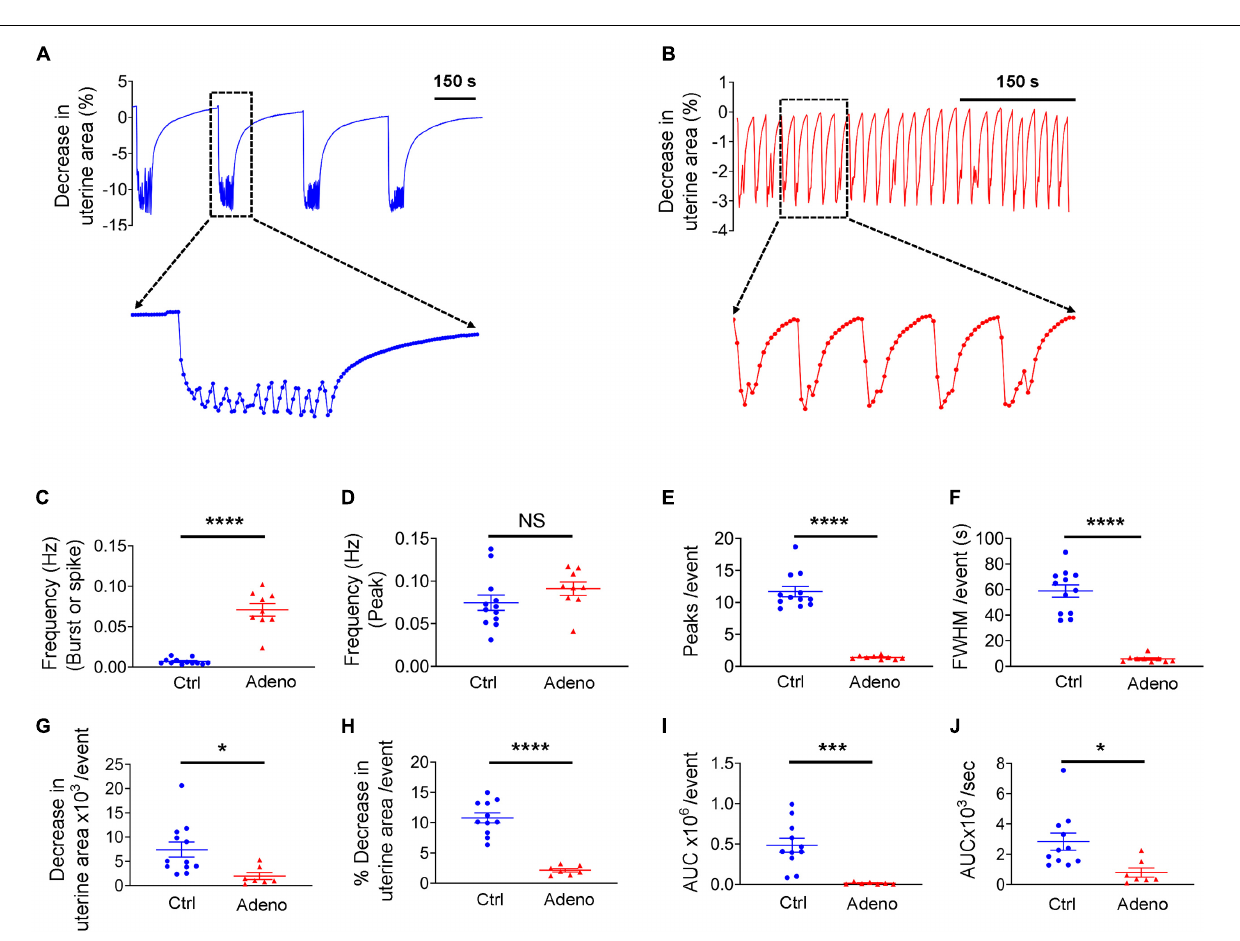
FIGURE 7 | Changes in uterine peristalsis in neonatal adenomyotic mice. (A) Typical peristalsis events in uterine slices from postnatal day (PND) 14 mice after treatment with the vehicle for tamoxifen (Ctrl). A burst event as marked with the dotted line box is shown in an expanded time scale. (B) Typical peristalsis events in uterine slices from PND14 mice after treatment with tamoxifen (Adeno). Five events marked with the dotted line box are shown in an expanded time scale. (C) Frequency comparison between Ctrl mice and Adeno mice at PND14 when a burst or a spike was counted as an event (the same convention is applied to panels E–J ). (D) Frequency comparison between Ctrl mice and adeno mice at PND14 when a peak was counted as an event. (E) Comparison on peak numbers/event between Ctrl and Adeno mice at PND14. (F) Full width at half maximum (FWHM)/event in Ctrl and Adeno mice at PND14. (G) Changes in uterine slice absolute areas/event in Ctrl and Adeno mice at PND14. (H) Changes in slice relative areas/event in control and adenomyotic mice. (I) AUC/event in Ctrl and Adeno mice at PND14. (J) Contraction intensity (AUC × Frequency) comparison between Ctrl and Adeno mice at PND14. Note that each data point in panels (C–J) is an average value from multiple slices in a mouse, and each slice was recorded for ∼ 1 h. N.S., no statistical significance, * P < 0.05, *** P < 0.001, **** P < 0.0001 with unpaired Student’s t -test [ N = 11 Ctrl mice (40–44 slices) and 9 Adeno mice (24–29 slices) for panels C–J